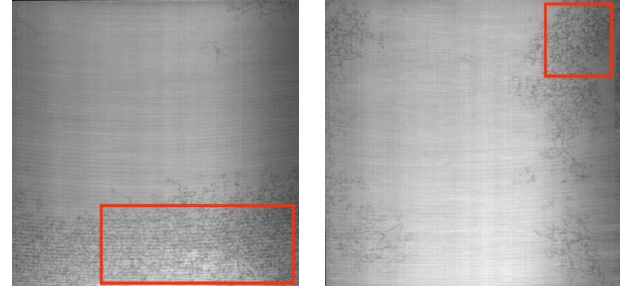
Figure 6. Schematic diagram of areas with a high density of dislocations.